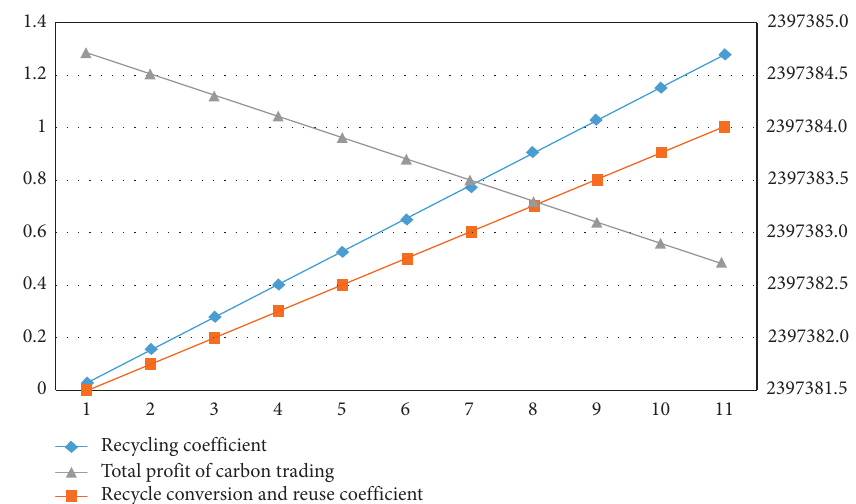
Figure 3: Change of total profit of carbon trading with r